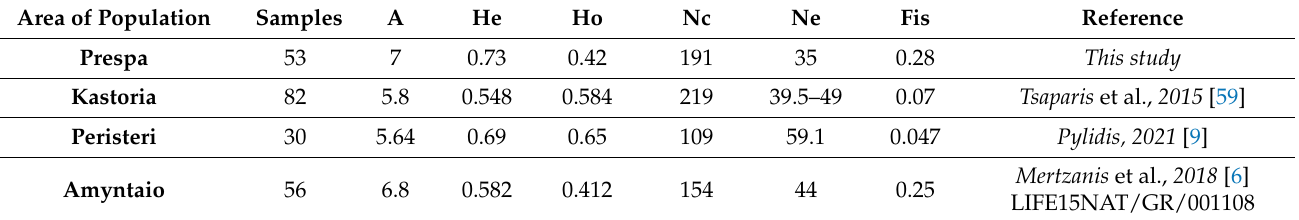
Table 9. Comparative table with studies carried out in Prespa NP and in areas close to Prespa (number of alleles (A); expected heterozygosity (He); observed heterozygosity (Ho); census population size (Nc); effective population size (Ne); inbreeding coefficient (Fis)).